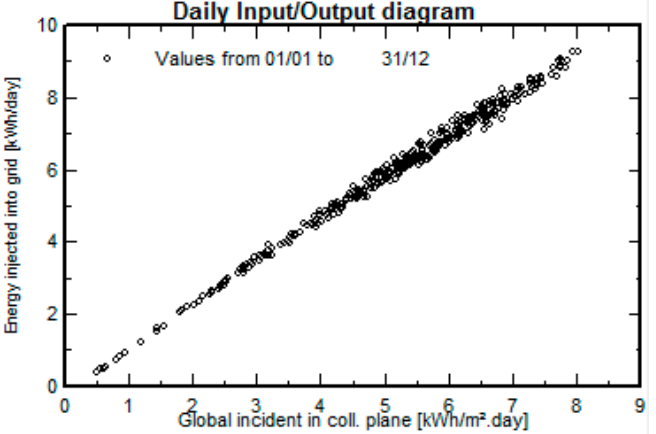
Figure 7. Correlation between energy injected into the grid according to daily insolation levels.